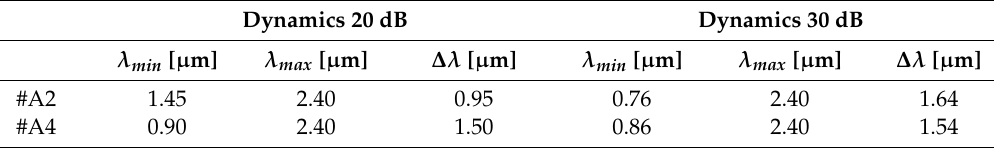
Figure 16. Measured supercontinuum spectra for the fibers #A2 and #A4 and P avg = 660 mW. For clarity characteristics are separated vertically by 20 dB. Table 8. Width of the supercontinuum spectrum for the fibers #A2 and #A4.